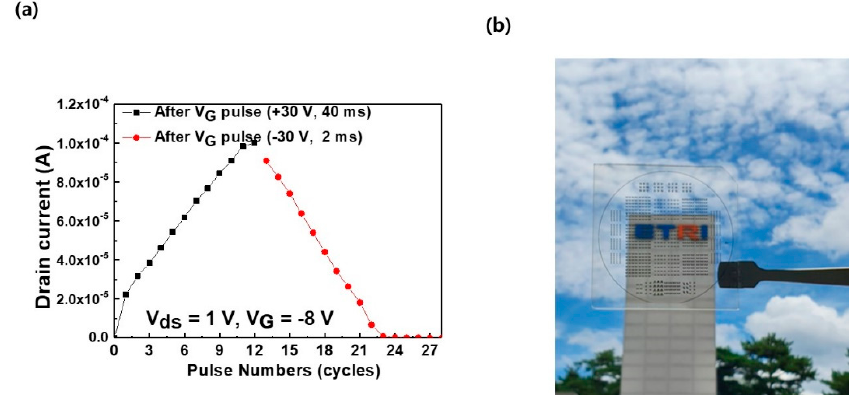
Figure 4. Devices fabricated on a glass substrate and connected in series and parallel, with transparent films of Ga-doped ZnO employed as the gate electrode. ( a ) Variation in drain current with number of pulses, exhibiting a linear and a symmetric relationship of excitatory and inhibitory behaviors, and ( b ) photograph of transparent devices except opaque Al metal electrodes.